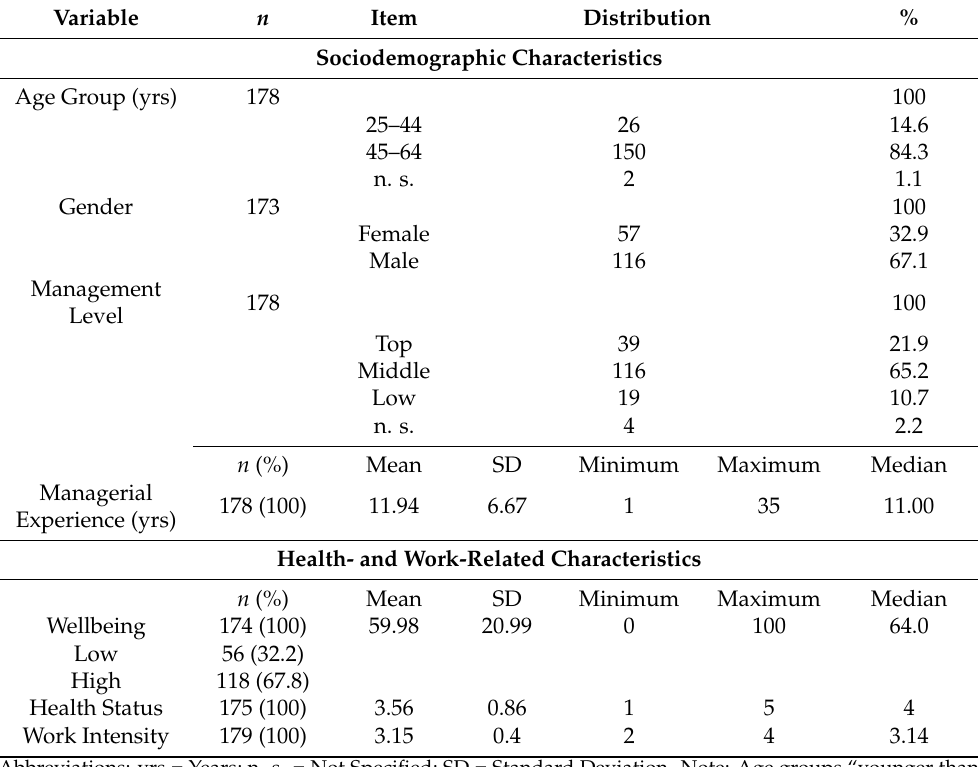
Table 1. Descriptive Statistics of Managers’ Sociodemographic, Health-, and Work-Related